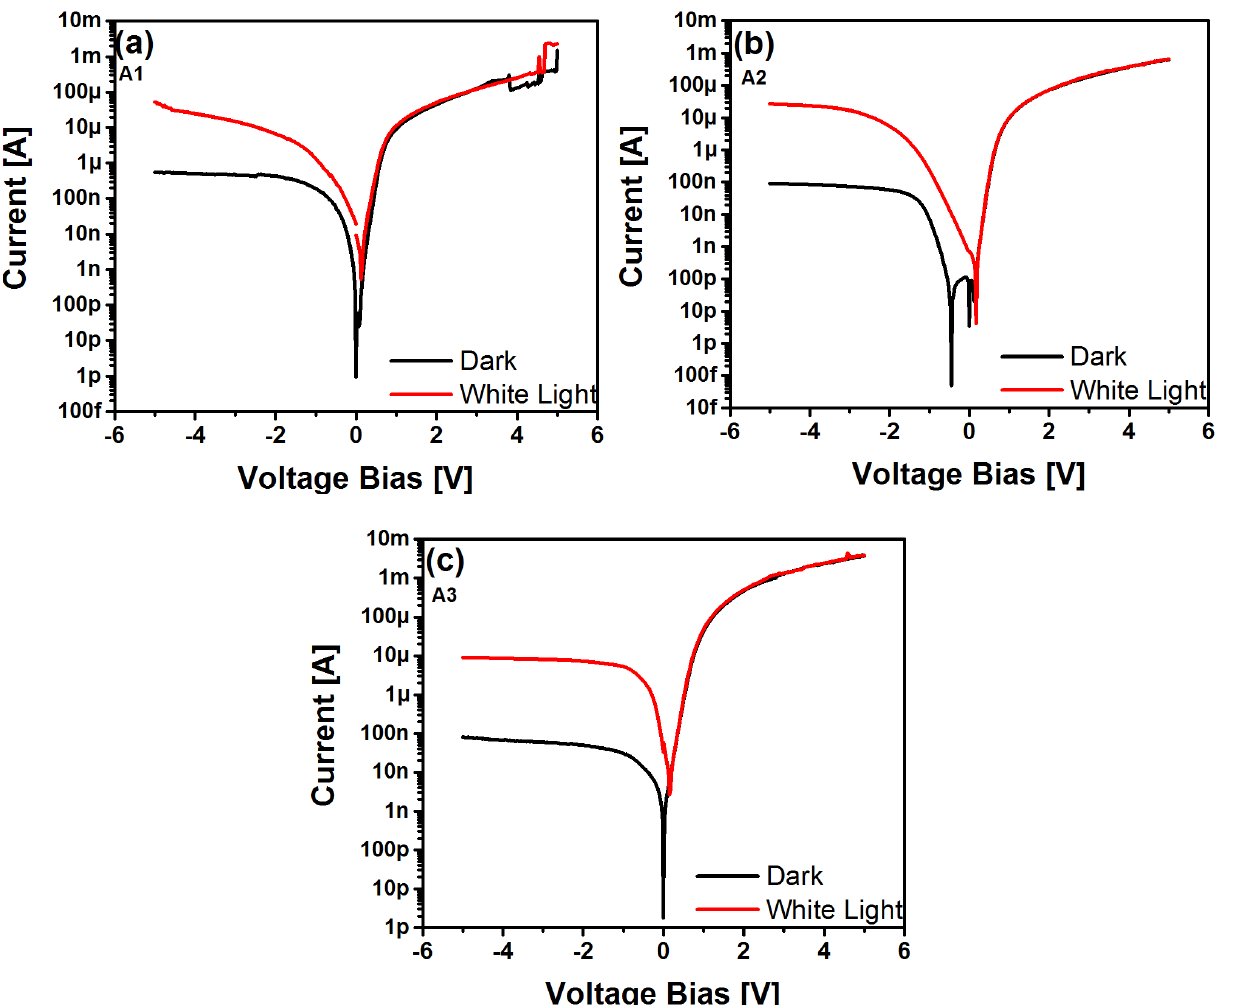
Figure 9. I-V curves of Au/SRO/Si structure with SRO A1 ( a ), A2 ( b ) and A3 ( c ) films under dark and white light illumination.